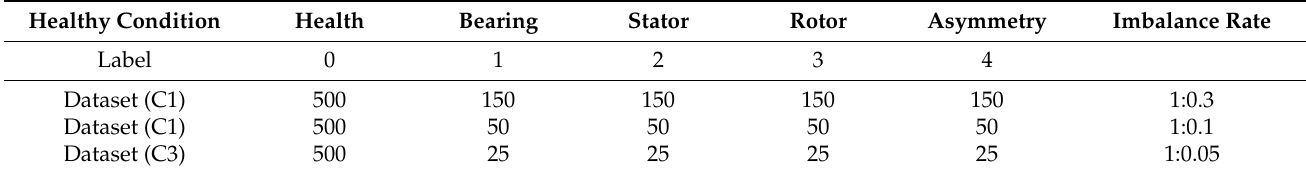
Table 6. Actual data with Imbalance